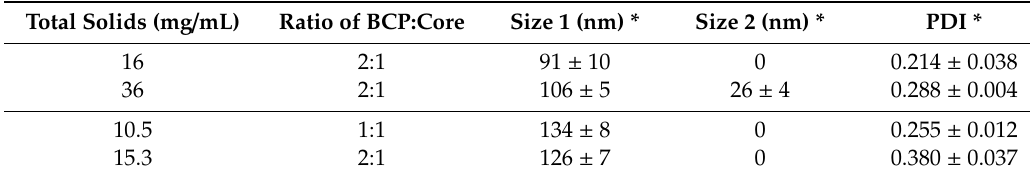
Table 2. Summary of lapatinib nanoparticle formulations.